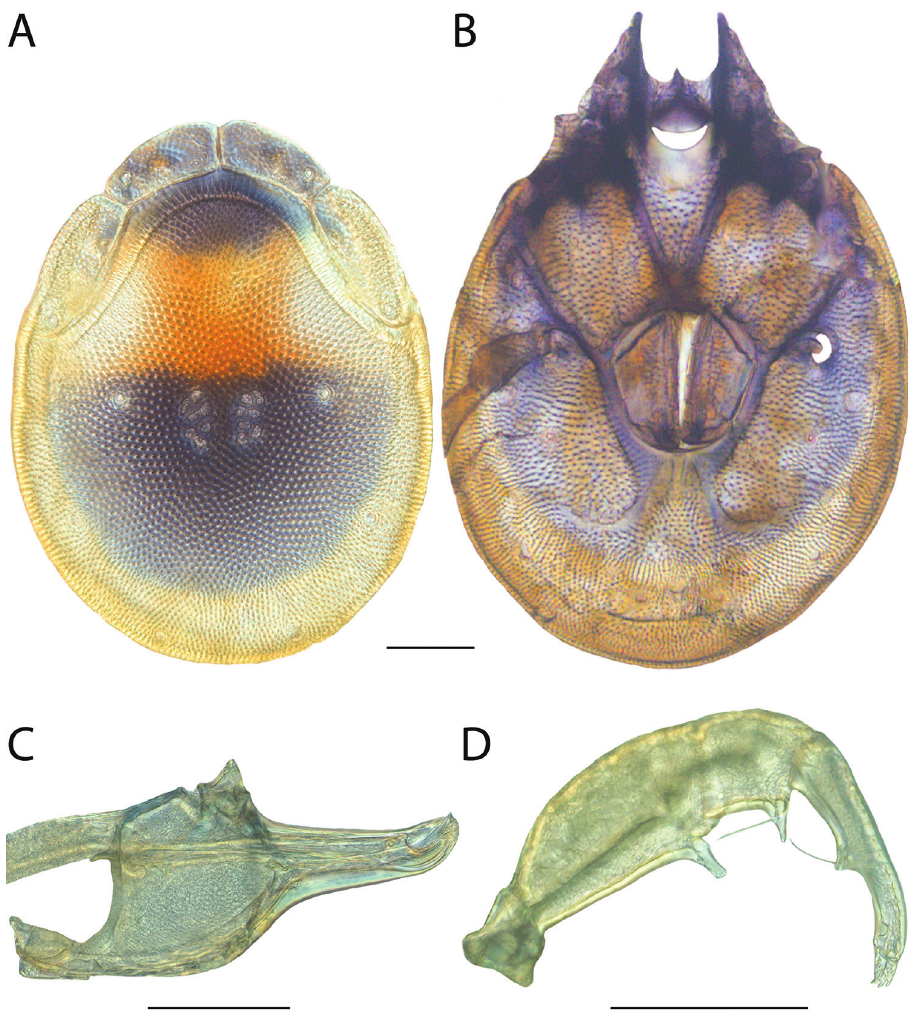
Figure 103. Torrenticola irapalpa sp. n. female: A dorsal plates B venter (legs removed) C subcapitulum D pedipalp (setae not accurately depicted). Scale = 100